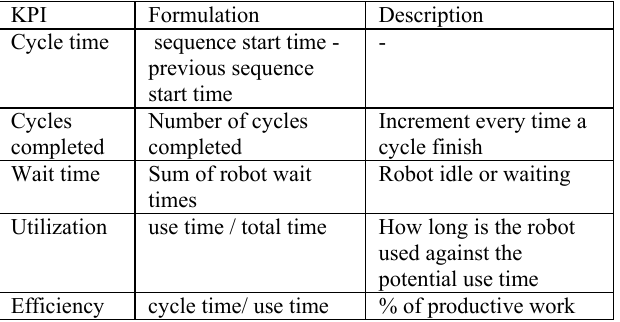
Table 1. Implemented KPIs on the monitoring